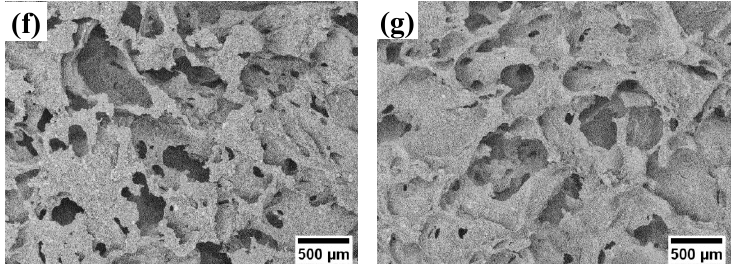
Figure 1. SEM images of the porous nHA/S composites containing ( a ) 30 wt% (H7S3), ( b ) 40 wt% (H6S4), ( c ) 50 wt% (H5S5), ( d ) 60 wt% (H4S6), ( e ) 70 wt% (H3S7), ( f ) 80 wt% (H2S8), and ( g ) 90 wt% (H1S9) of starch proportion.